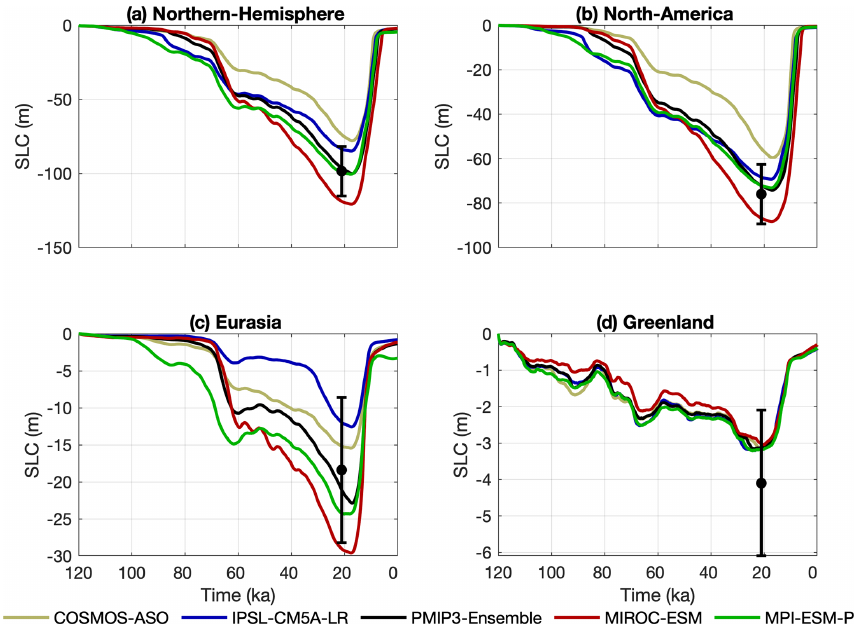
Figure 3. Sea level contribution of the Northern Hemisphere ice sheets using the climate matrix method and the uncertainty range of LGM ice volume from Simms et al. (2019). Each simulation was forced with a climate obtained from a member of the PMIP3 ensemble.